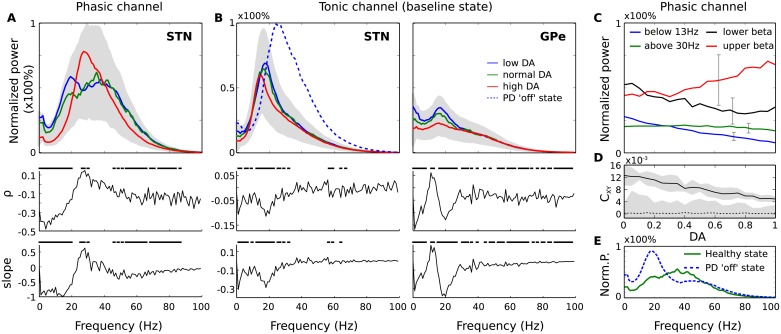
Frequency spectrum of STN-GPe loop without oscillatory input.Dopamine reduces lower-beta oscillations and modulates the spectrum. A, B: Up: Average power spectrum for different dopamine levels during the phasic (A) and tonic fixed (B) state of a single microscopic channel in the level of the STN and GPe. The spectrum is normalized by the maximum value of STN power in A, and both STN and GPe in B. The light grey areas represent the standard deviation of the average power spectrum for random dopamine levels between 0 and 1 (n = 4000). Down: Spearman’s rank correlation coefficient (ρ) and the slope of best-fit regression line between frequency power and DA levels measured in the above runs. The black lines indicate areas where p-value is less than 0.05. C: Mean power of the four interesting frequency bands for different plausible dopamine levels, during the phasic state of a microscopic channel in STN. D: Average cross-correlation between the firing rates of each neuron in the STN, presented for different levels of dopamine and used as a measure of synchrony within the STN. The solid line represents correlation when stimulation to the BG is applied transiently, after the subtraction of the same statistic produced by surrogate data, while the dashed line shows the result of stimulation over a long time period. E: Average power spectrum of a phasic STN channel under healthy and PD conditions. In all cases, the shaded areas or lines represent standard deviation.